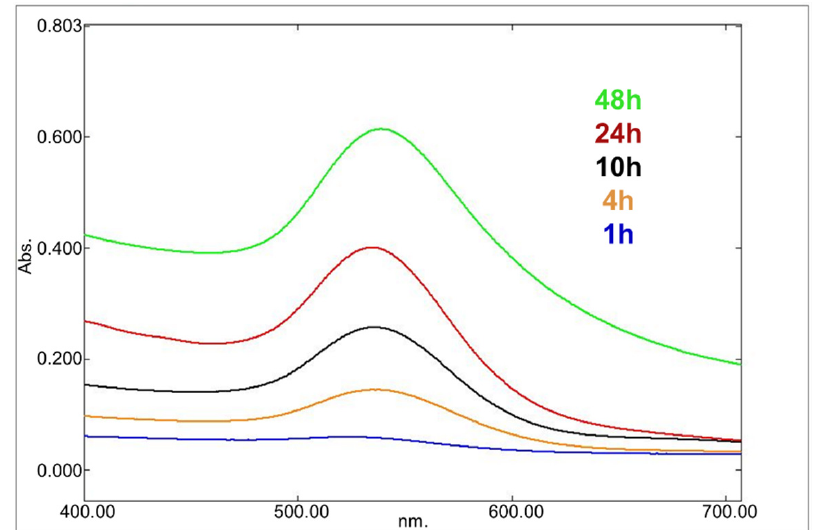
Figure 3. UV-Vis analysis of the nanoparticle-containing toluene layer of the phase transfer reaction mixture at different time intervals. n-Butylsilane was the phase transfer agent.